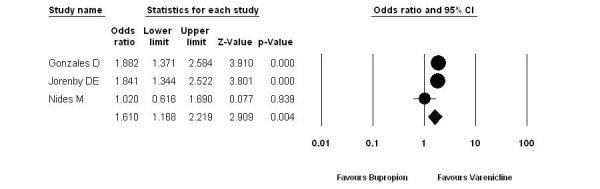
Random Effects Meta-Analysis. Varenicline vs. Bupropion at 3 months. I2 = 56.1%.